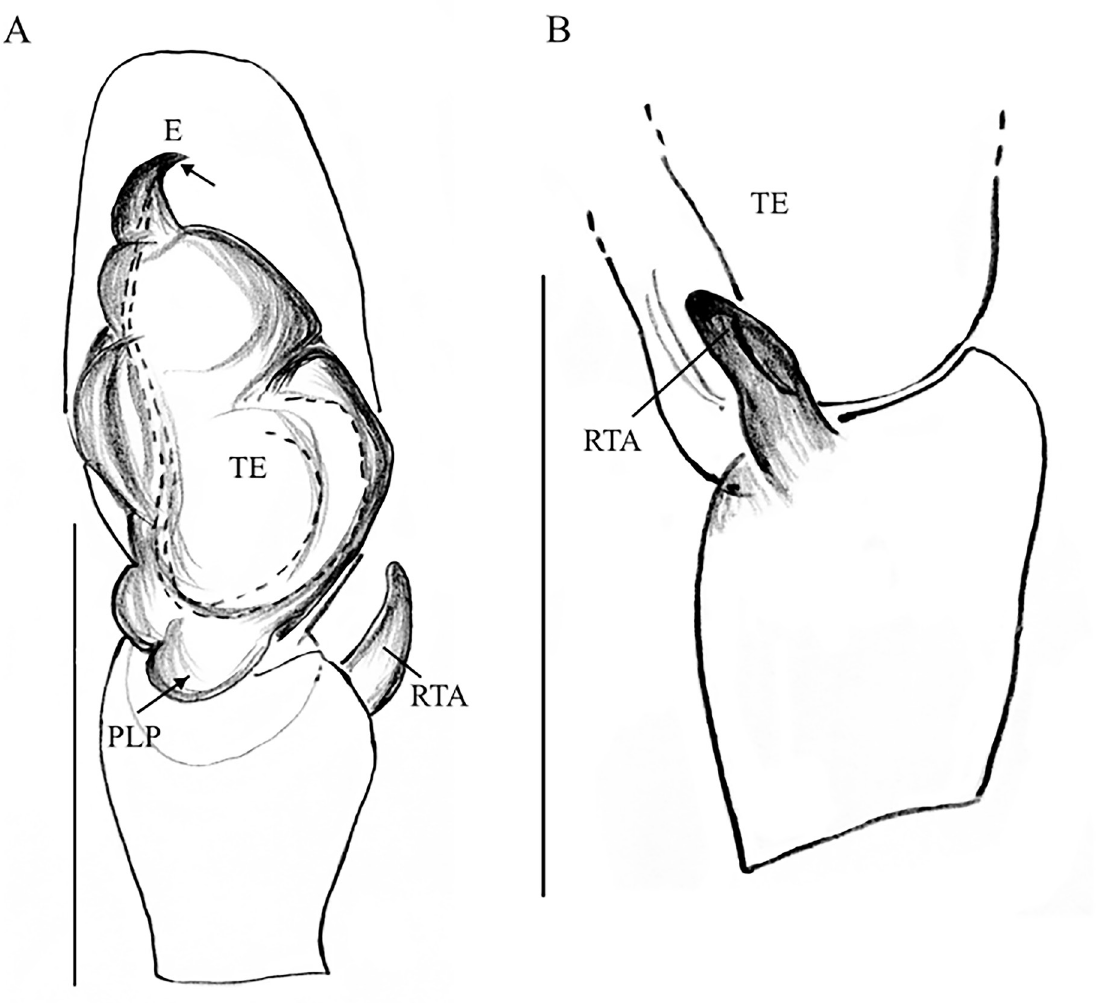
Fig 9. Carrhotus lobatus sp. nov., palp. A . Ventral view. B . Retrolateral view. Abbreviations: E = embolus; PLP = posterior lateral protrusion; RTA = retrolateral tibial apophysis; TE = tegulum. Scale bars = 0.2